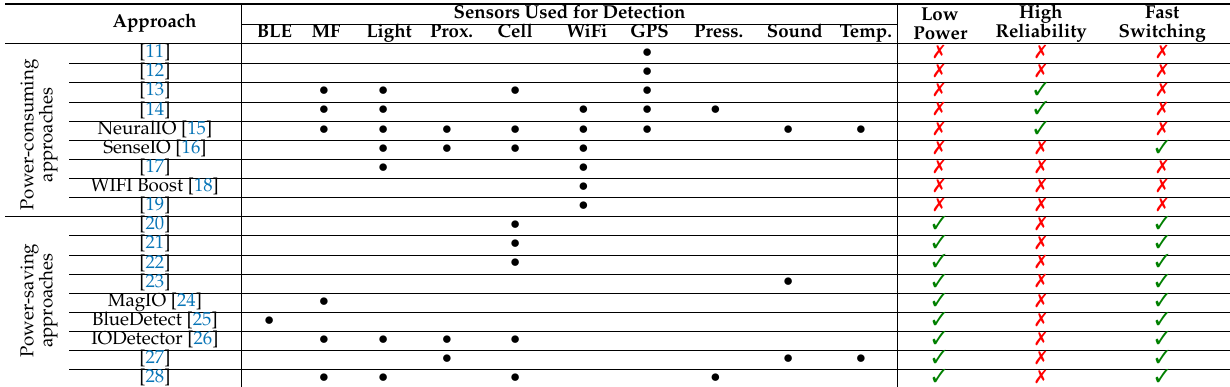
Approach Sensors Used for Detection Low